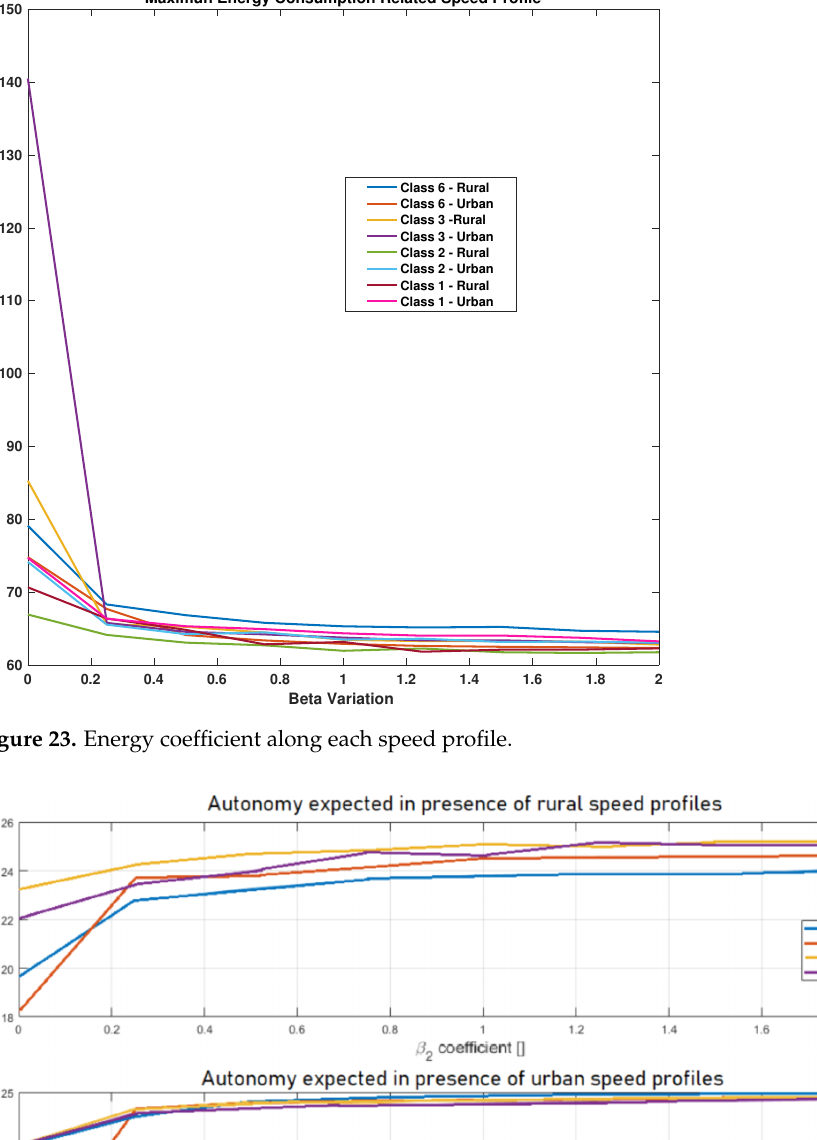
are provided in Table